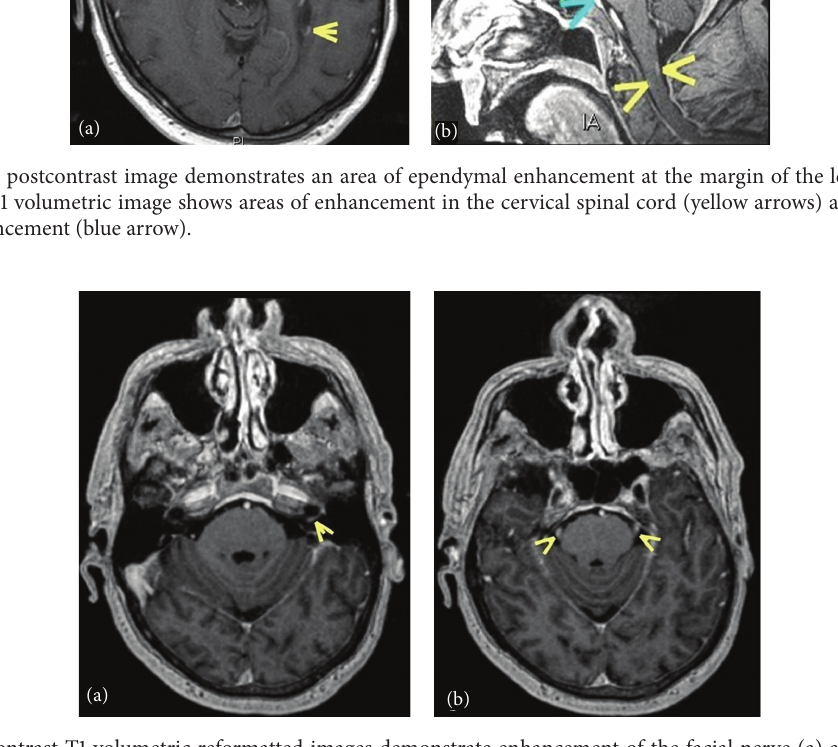
Figure 3: Axial postcontrast T1 volumetric reformatted images demonstrate enhancement of the facial nerve (a) and bilateral trigeminal nerves